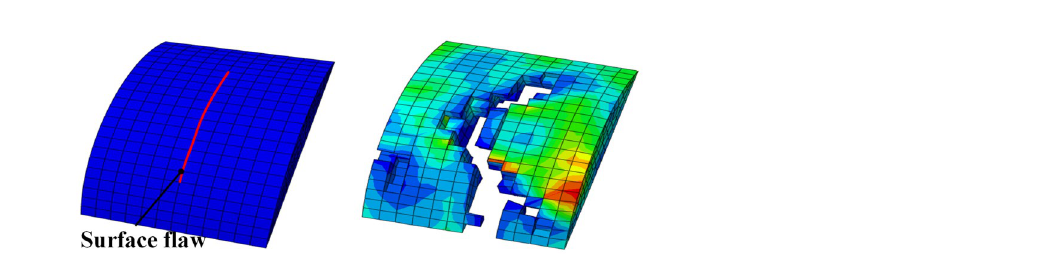
Figure 13. Deformation by depth, width, and length of the surface flaw on the OT wire during the manufacturing process.